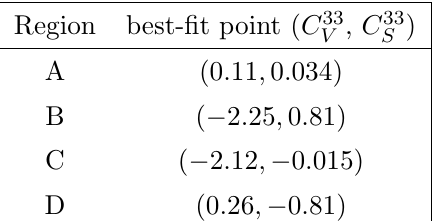
Table 2. The best-(cid:12)t points for our (cid:31) 2 (cid:12)t to the b ! c(cid:28)(cid:23) data for (cid:3) = 1 TeV. Four distinct regions emerge from our analysis, of which region A is the most convenient to attain in a UV complete model, since it involves small values of the Wilson coe(cid:14)cients and guarantees perturbative Yukawa couplings.